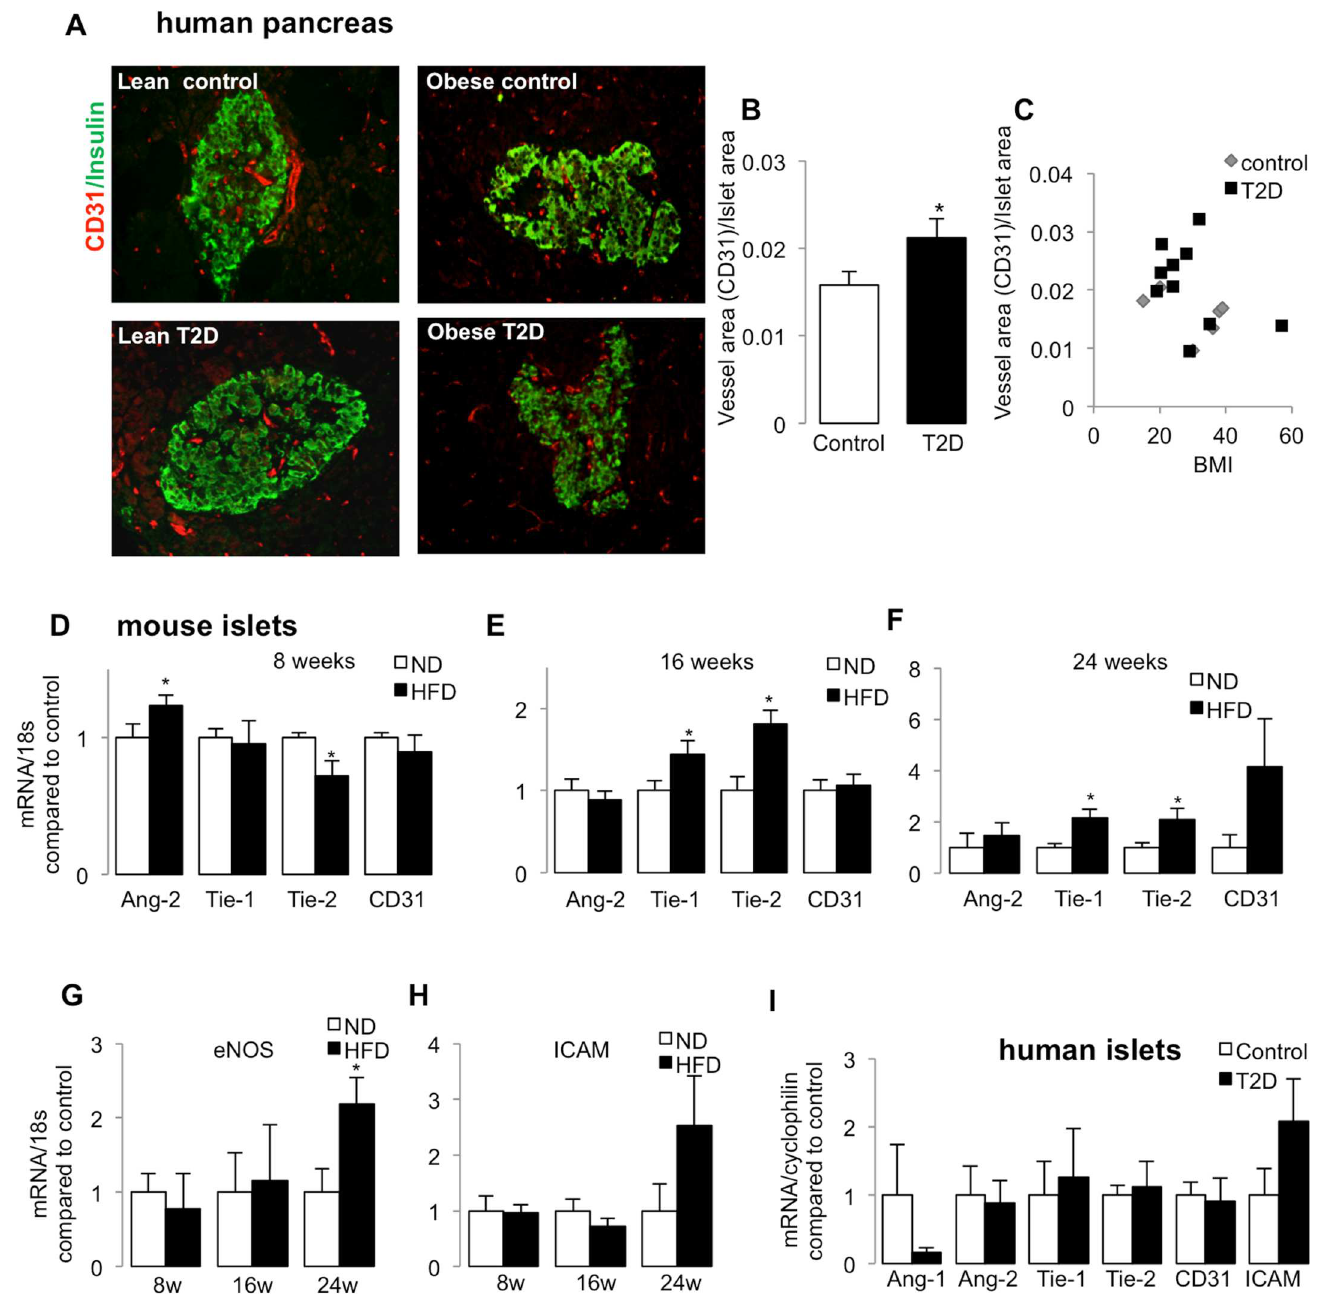
Fig 1. Isletvesselarea increases in T2DM.(A) Representative imagesof pancreaticsectionsfromnon-diabeticcontrolsand patientswith T2D, immune-labelled for CD31 (red)and insulin (green). (B) Graphs show ratio of vessel area to islet area (control:n = 6; T2D: n = 10). (C) Plot shows no correlationof vessel density with BMI. (D-H) qPCR analysis of Ang-2,Tie-1,Tie-2,CD-31fromisolatedmouse islets fromC57BL/6WT mice kept on normaldiet (ND)or high-fat high-sucrose diet (HFD)for (D) 8 weeks (n = 4/group), (E) 16 weeks (n = 9/group) and (F) 24 weeks (n = 7/group), (G)of eNOS and (H) of ICAM-1. (I) qPCR analysis of Ang-1,Ang-2,Tie-1 and Tie-2of isolatedislets fromnon-diabetic (control,n = 8) and frompatientswith T2D (n = 7). * p < 0.05,HFD vs ND or T2D vs. control (2.2-fold, Fig 1G), and a strong tendency of ICAM-1 increase (2.5-fold, Fig 1H) in HFD as well as in human T2D islets (Fig 1I), a marker known to be associated with leukocyteinfiltration. No